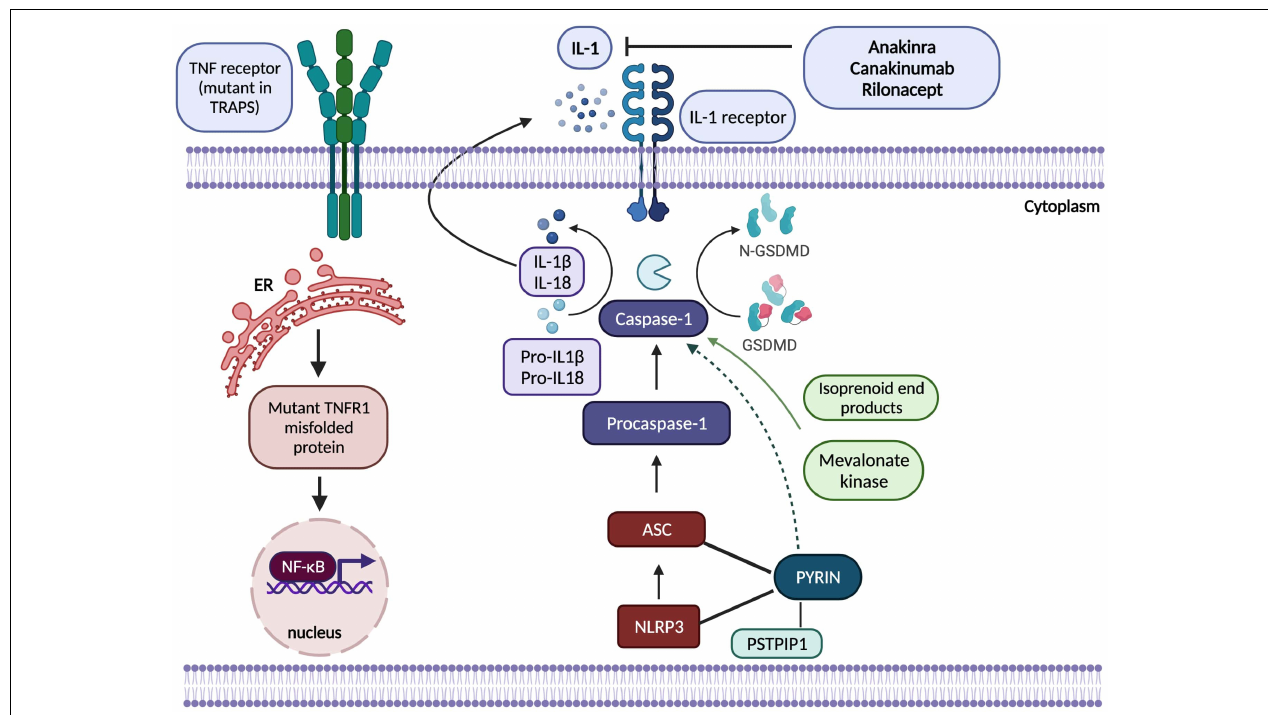
FIGURE 1 | Adapted from Kastner et al. (2) a schematic showing pathogenesis of hereditary autoinflammatory diseases regulated by IL-1ß (inflammasomopathies) and NF- κ B (Created by Biorender). In CAPS, NLRP3 protein interacts with the adaptor protein ASC and caspase-1 to form the inflammasome complex which activates IL-1ß and IL-18 and results in inflammatory responses. Mutations in pyrin, PSTPIP1, NLRP3, mevalonate kinase proteins shown in the figure disrupt normal functioning of inflammasome complex. Mutations in NLRP3 increase the activation of the complex; however, mechanisms by which pyrin protein regulates inflammasome functioning have yet to be elucidated as theories involve both gain-of-function activation of pyrin-inflammasome complex and loss-of-function in its inhibitory effects on NLRP3. In TRAPS, mutant TNFR1 protein is misfolded in ER that causes accumulation of this protein, hence overactivation of NF- κ B resulting in abnormal inflammatory immune responses. IL-1-targetted biologic agents, anakinra, canakinumab and rilonacept have been effectively used to control inflammatory state in these prototypic monogenic SAIDs. ASC, Apoptosis-associated speck-like protein; ER, endoplasmic reticulum; GSDMD, Gasdermin D; IL-1, interleukin-1; NF- κ B, nuclear factor κ B; NLRP3, NOD, LRR and pyrin domain-containing protein; PSTPIP1, proline-serine-threonine phosphatase interacting protein 1; TNF, tumour necrosis factor, TNFR1, tumour necrosis factor receptor 1; TRAPS, TNF-receptor associated periodic